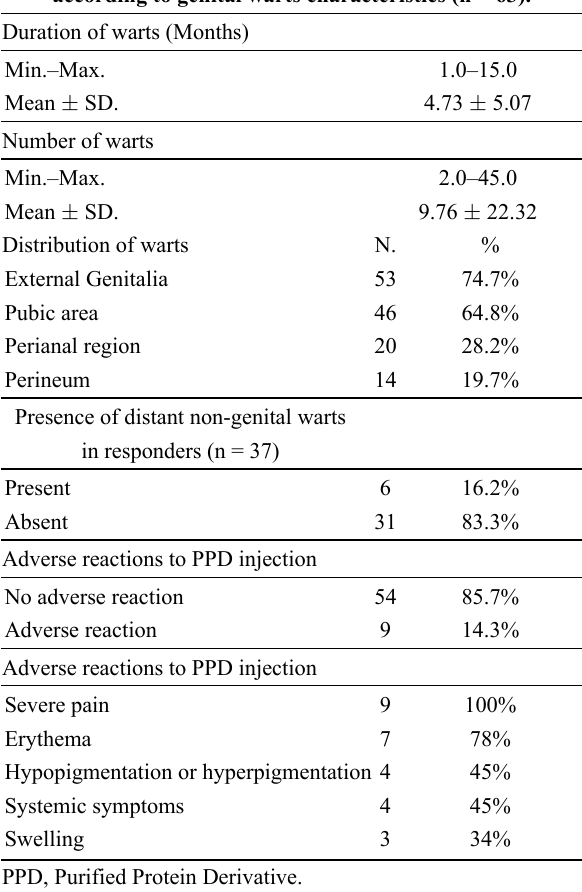
Table 2. Frequency distribution of the studied patients according to genital warts characteristics (n = 63).